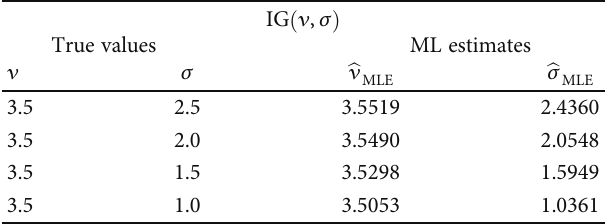
Table 1: True and parameter estimates for IG ð ν , σ Þ .